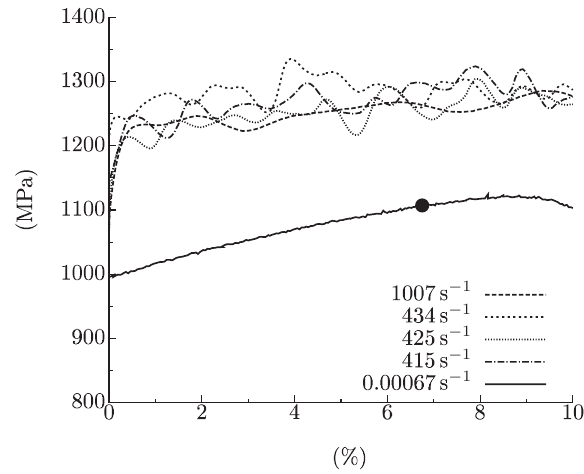
Fig. 7. True tensile diagram of as-received material at di ff erent strain rates. The point indicates the maximum uniform